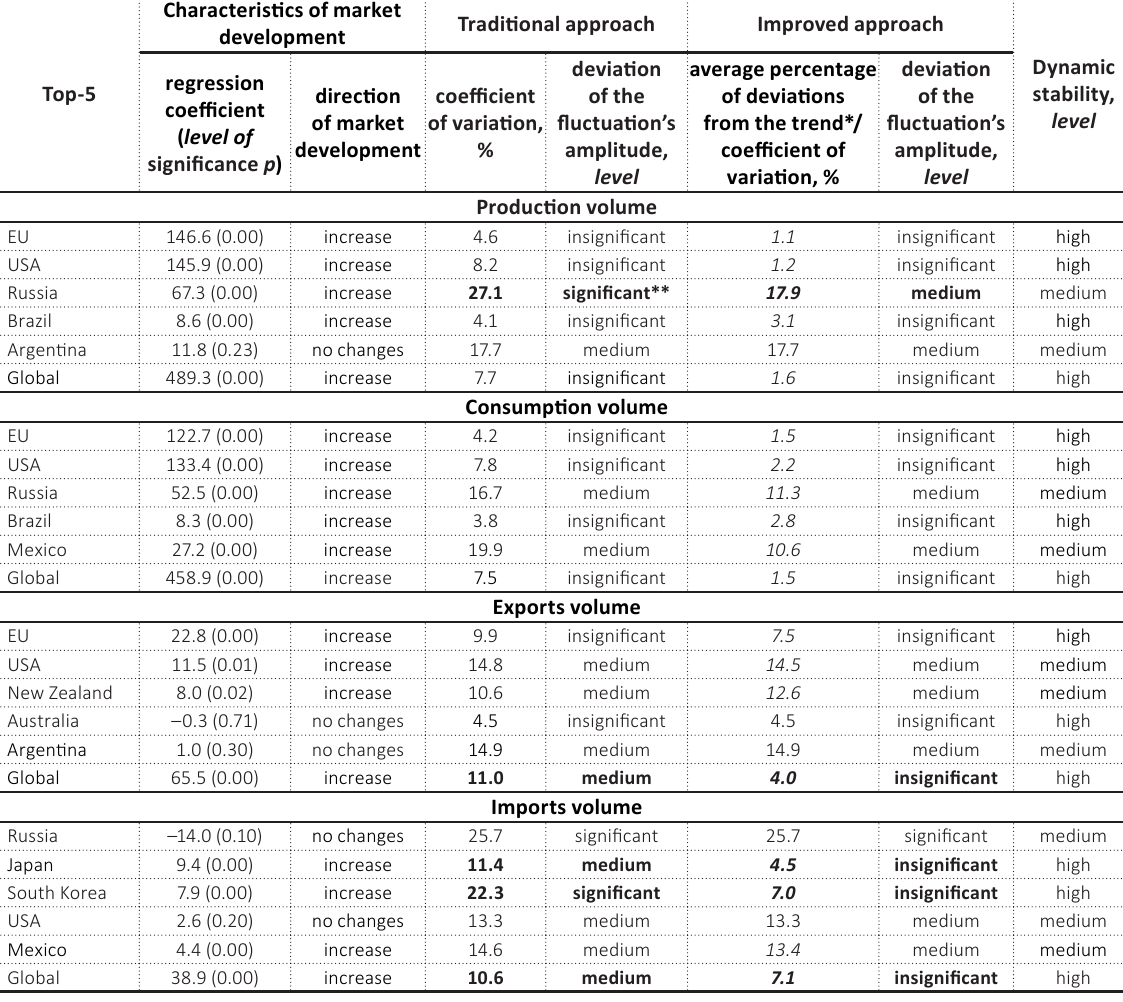
Table 1. Comparison of the traditional and improved approaches to assessing dynamic stability of the growth of the global cheese market in 2011−2020